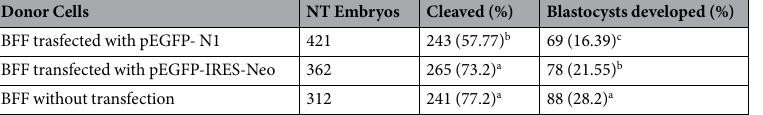
Table 1. In vitro development of SCNT embryos derived from BFFs transfected with different vectors. Data were from more than three replicates. a,b Within a column, values with different superscripts are significantly different ( P <